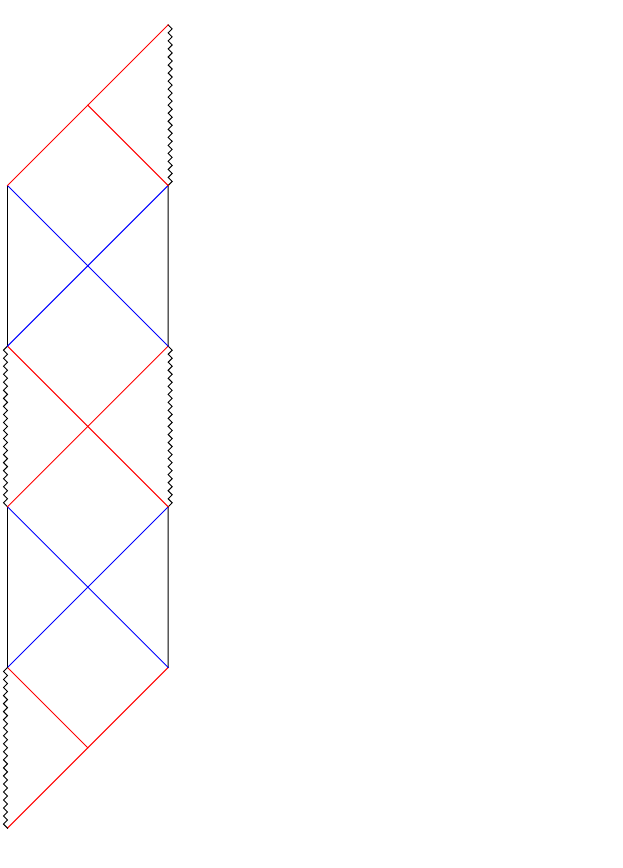
Figure 1 . The Penrose diagram of a non-extremal rotating or charged black hole in anti-de Sitter space. The diagram repeats in(cid:12)nitely in the vertical direction. Blue lines are outer horizons, red lines are inner horizons, and jagged lines are the timelike